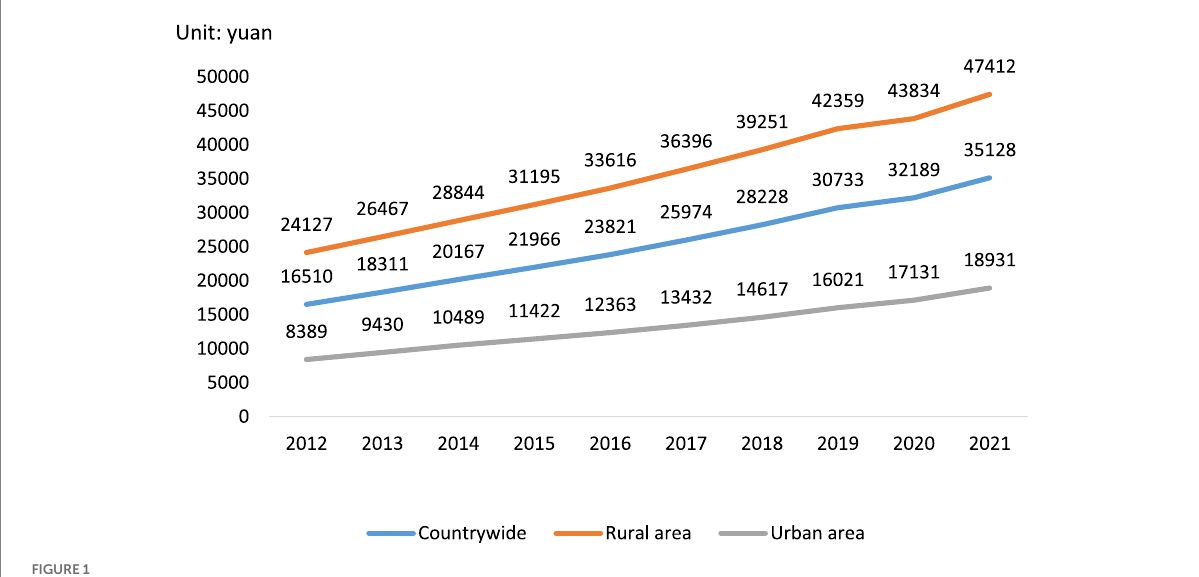
FIGURE 1 Disposable income per capita from 2012 to 2021. Data compiled by National Bureau of Statistics of China (2021).